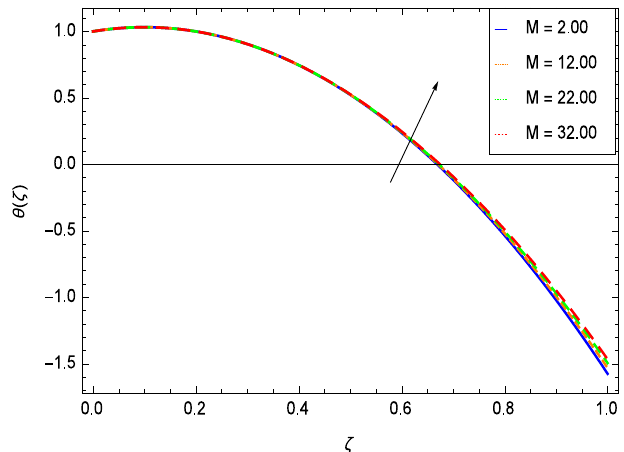
Figure 14. Conduction layer at h = − 3.00, β = 0.10, φ = 0.40, n = 1.50, We = 0.50, S = 0.50, Nr = 1.00, Pr = 10.00, A 3 = A 4 = 0.20, A = π with the enhancement in M . 4